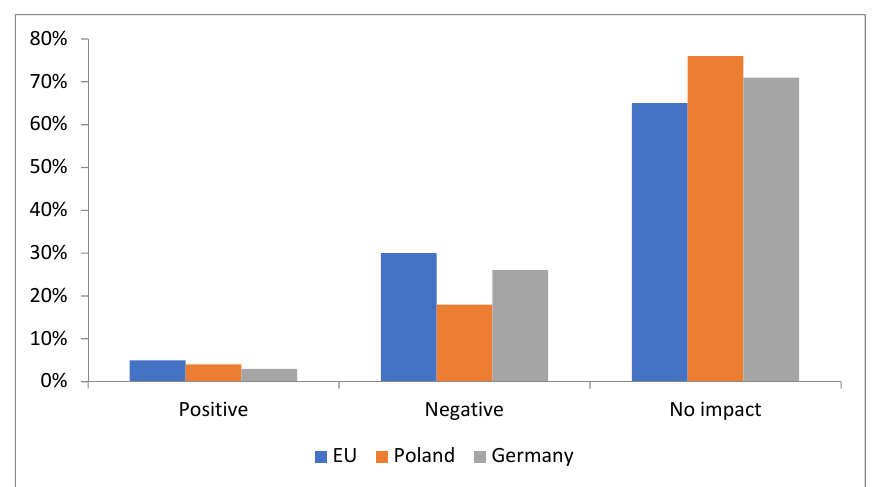
Figure 10. Opinion on the implementation of the supply chain.